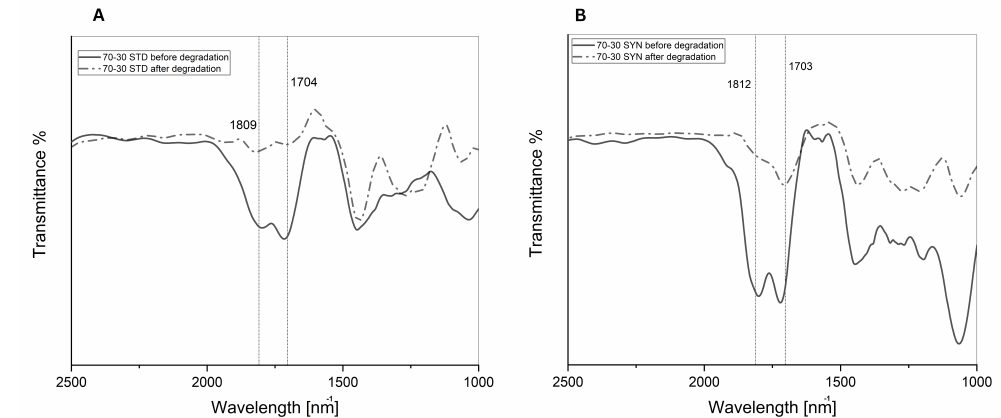
Figure 12. ( A ) Anhydride bond degradation in sample STD (70:30). ( B ) Anhydride bond degradation in sample SYN